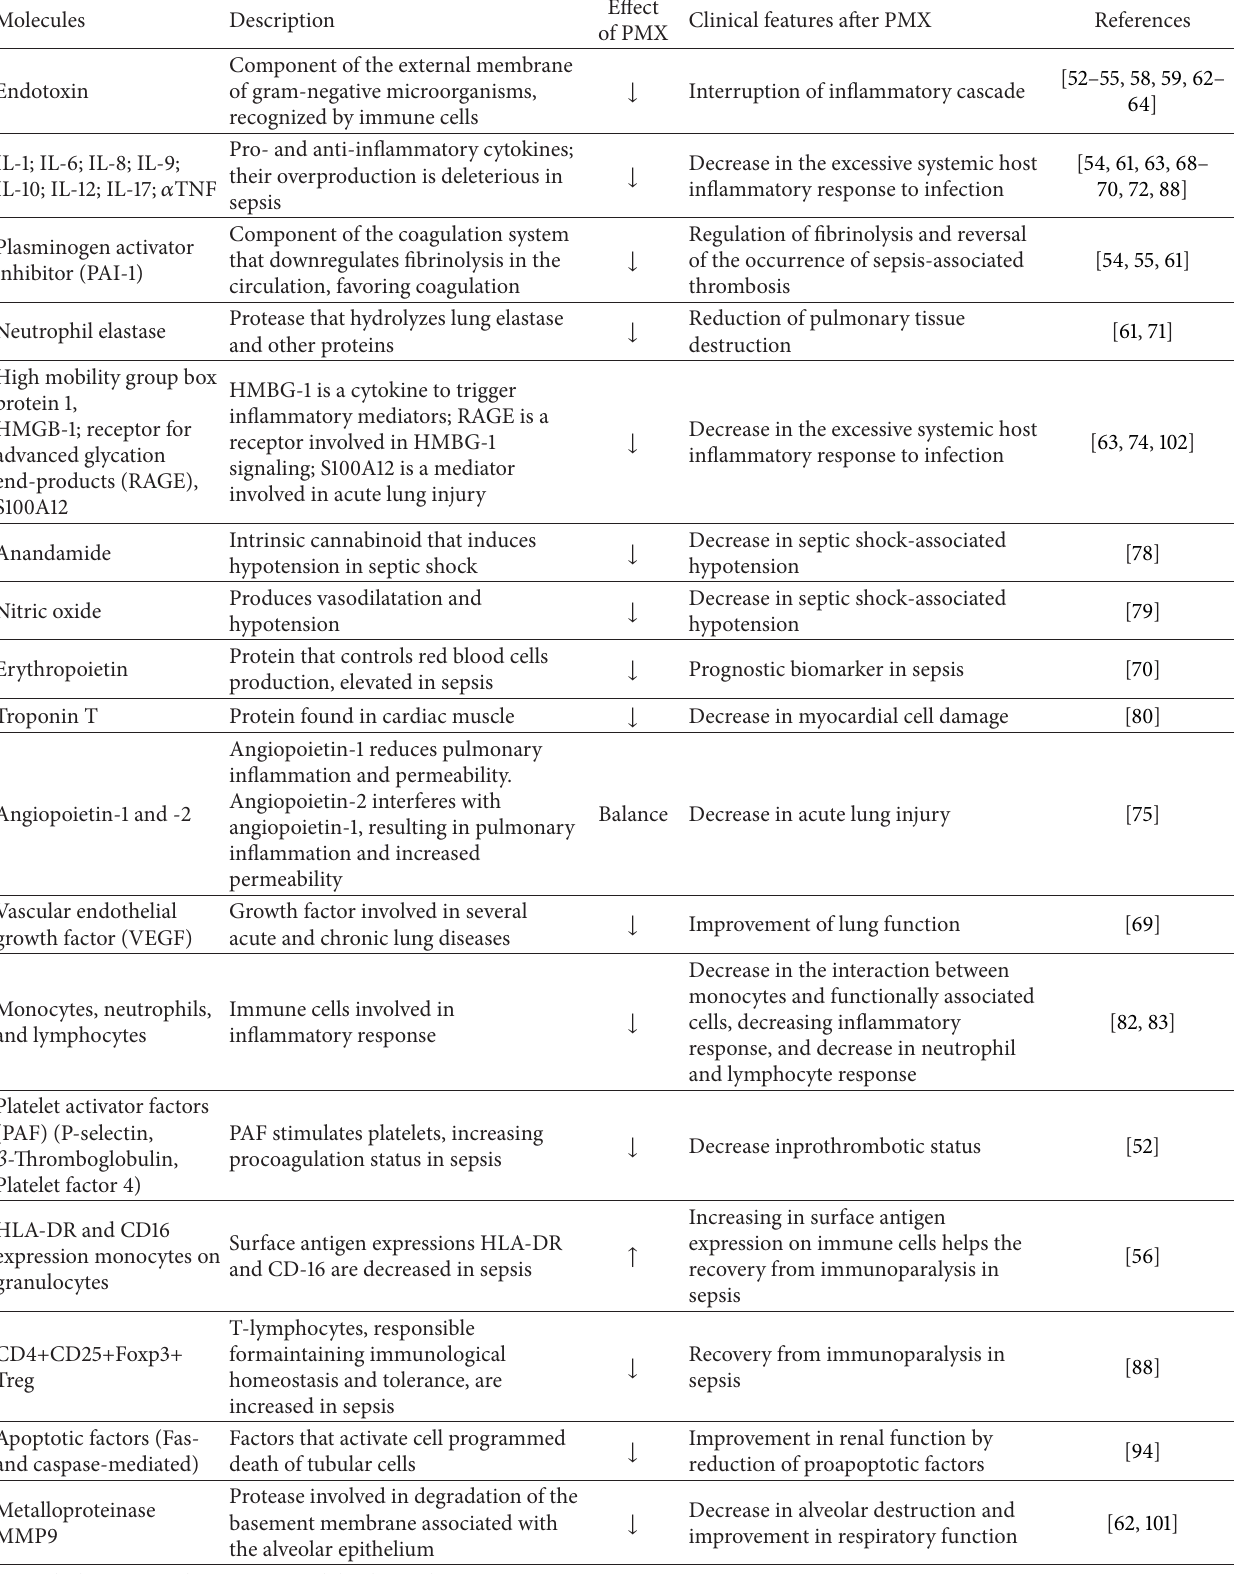
Table 2: Summary of mechanisms described for polymyxin B-immobilized cartridge hemoperfusion.